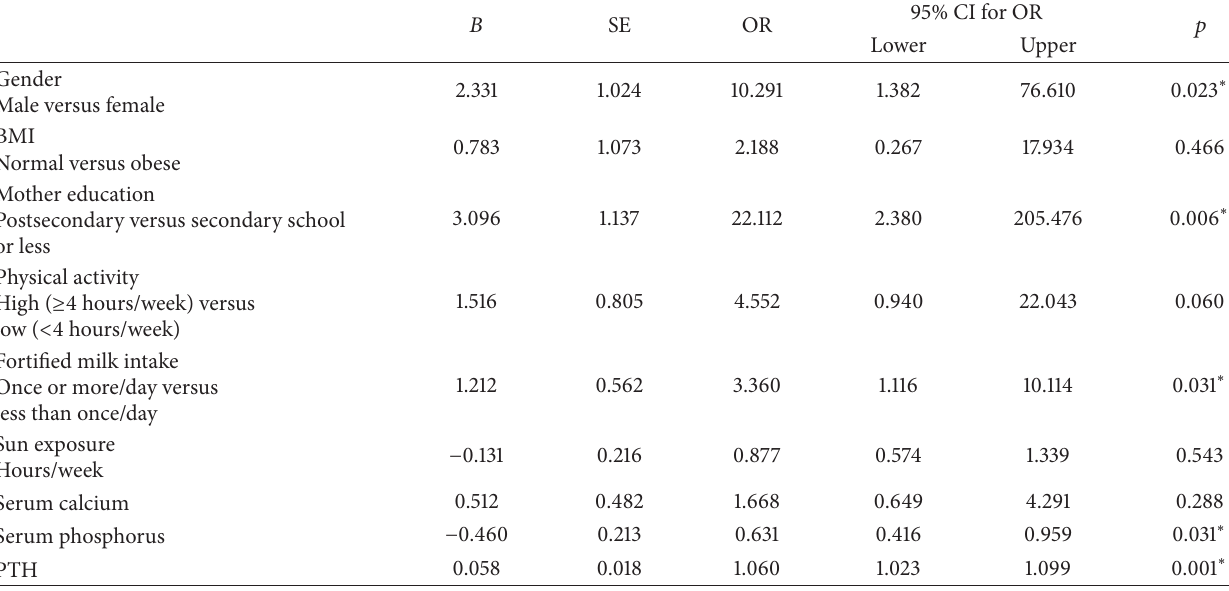
Table 3: Logistic regression for presumed risk factors for vitamin D deficiency (25(OH)D < 20 ng/mL). 𝐵 SE OR 95% CI for OR 𝑝 Lower Upper